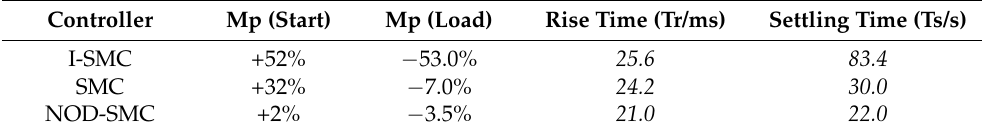
Table 2. The transient response data for the three controllers.